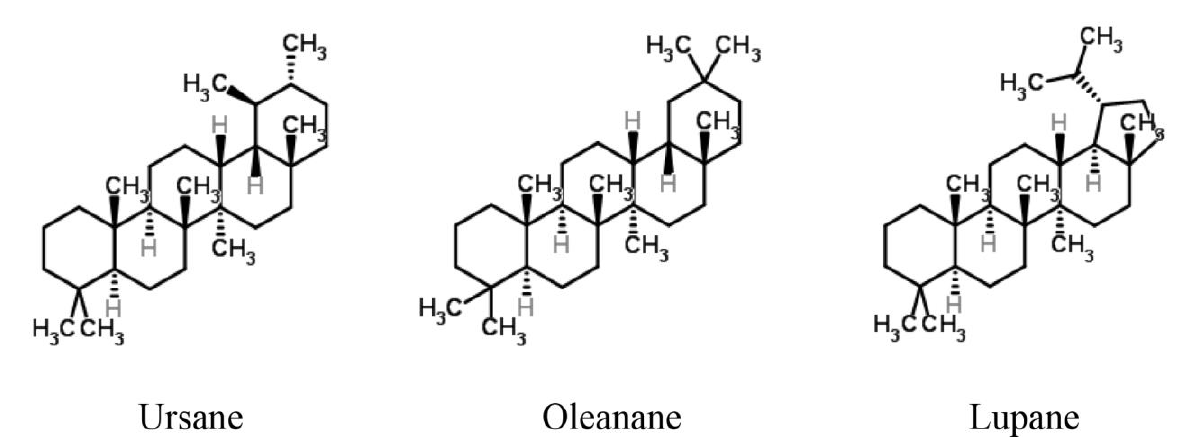
Fig. 3. The chemical structure of triterpene compounds, derivatives of which are found in herbs of M. fistulosa та O.